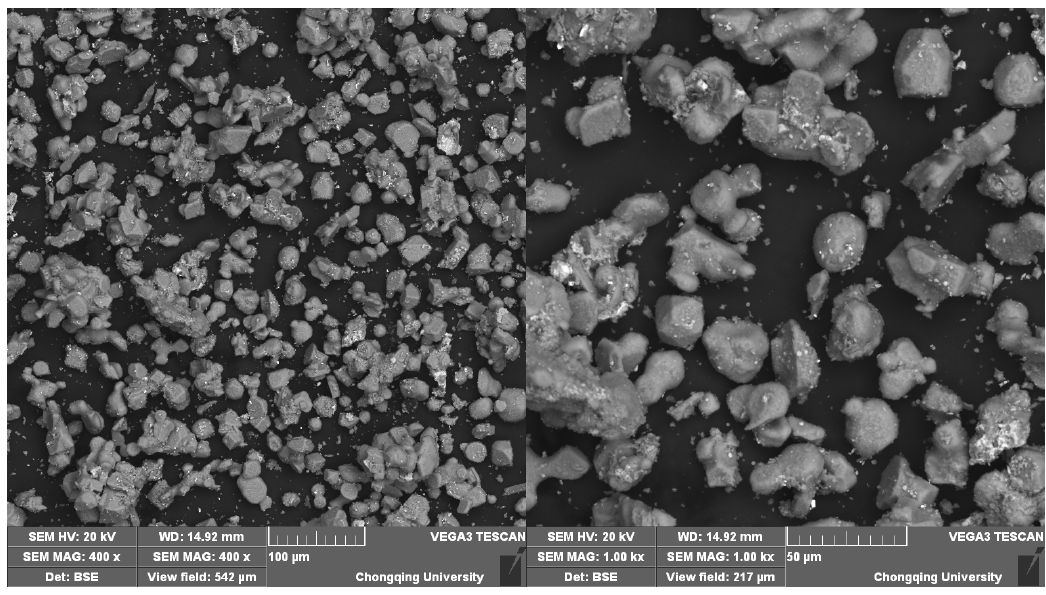
Figure 2. The morphology of sulfur waste.